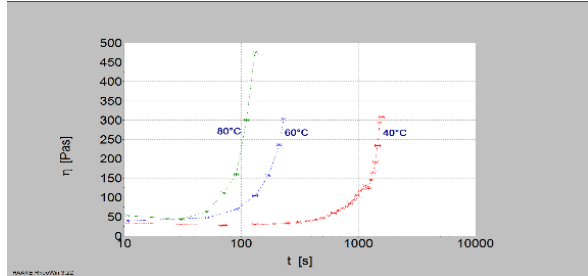
Figure 13: Effect of the temperature on the setting time